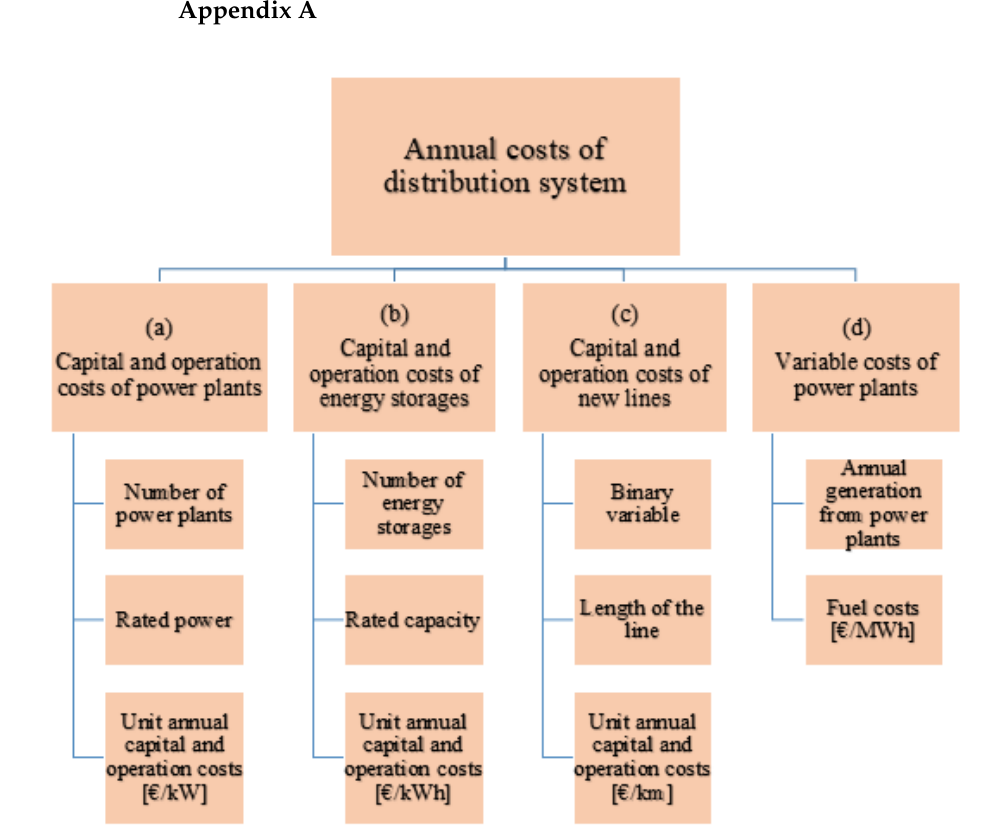
Figure A1. Scheme of the objective function. Table A1. Parameters of nodes.